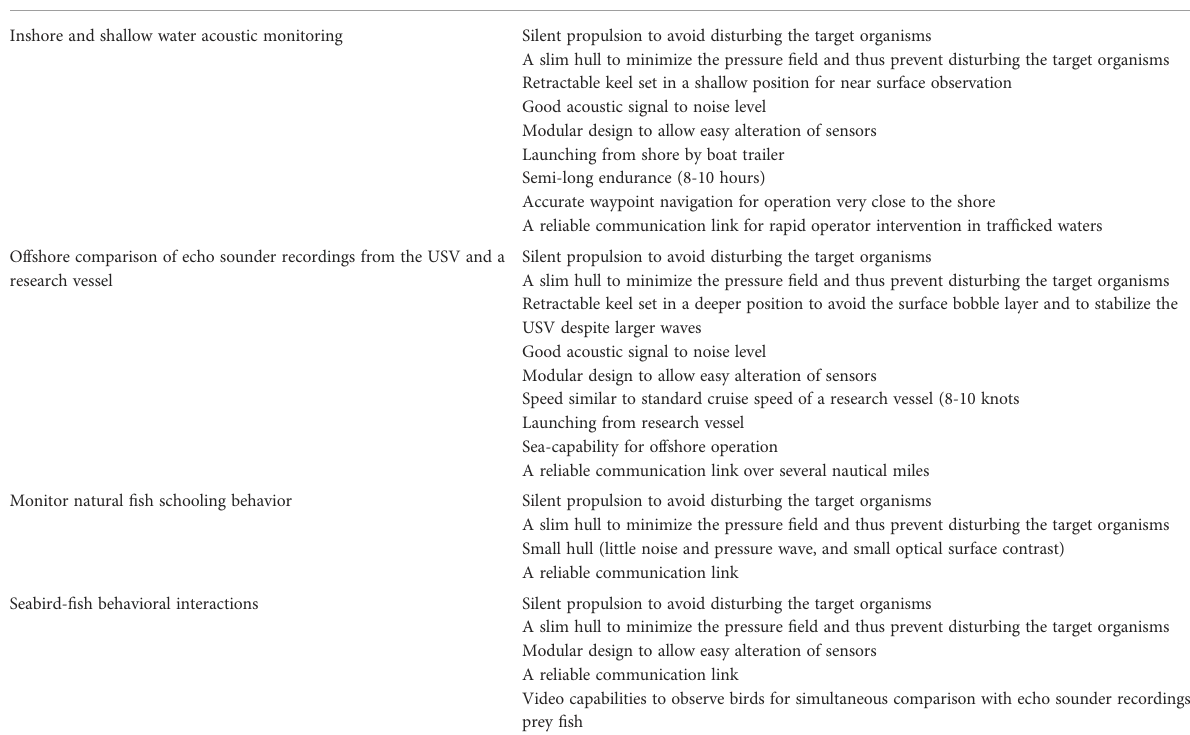
TABLE 1 Overview of the scienti fi c purposes and design criteria of the Kayak Drone. Purpose Design